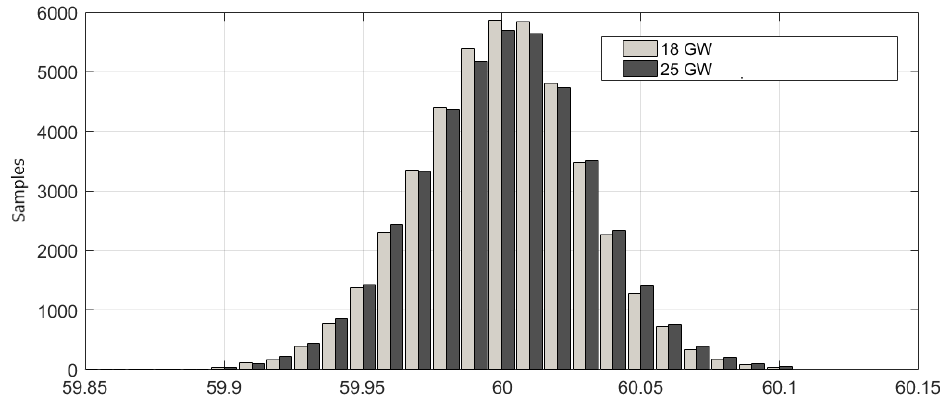
Figure 3. Histograms of system frequency for 18 GW and 25 GW of wind penetration scenarios.